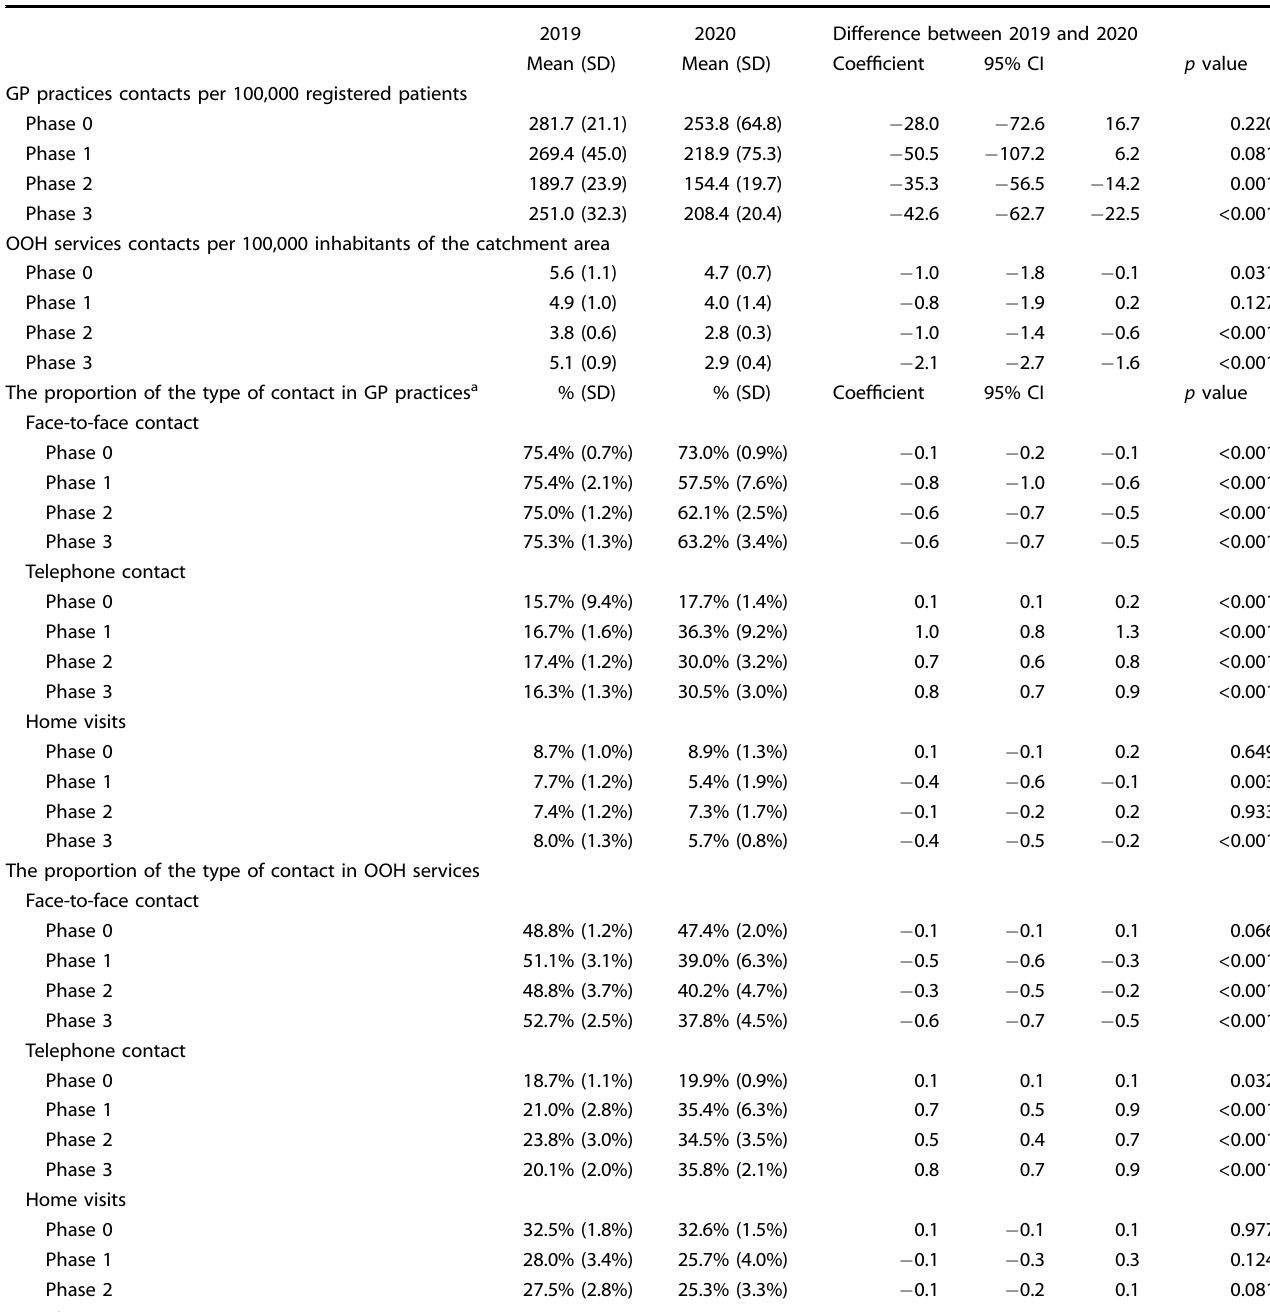
Table 2. Mean and standard deviation for the contact rates, the proportion of the type of contact (2019 and 2020), and differences in contact rates and the type of contact between 2019 and 2020 presented per phase of the COVID-19 pandemic, both for GP practices and OOH